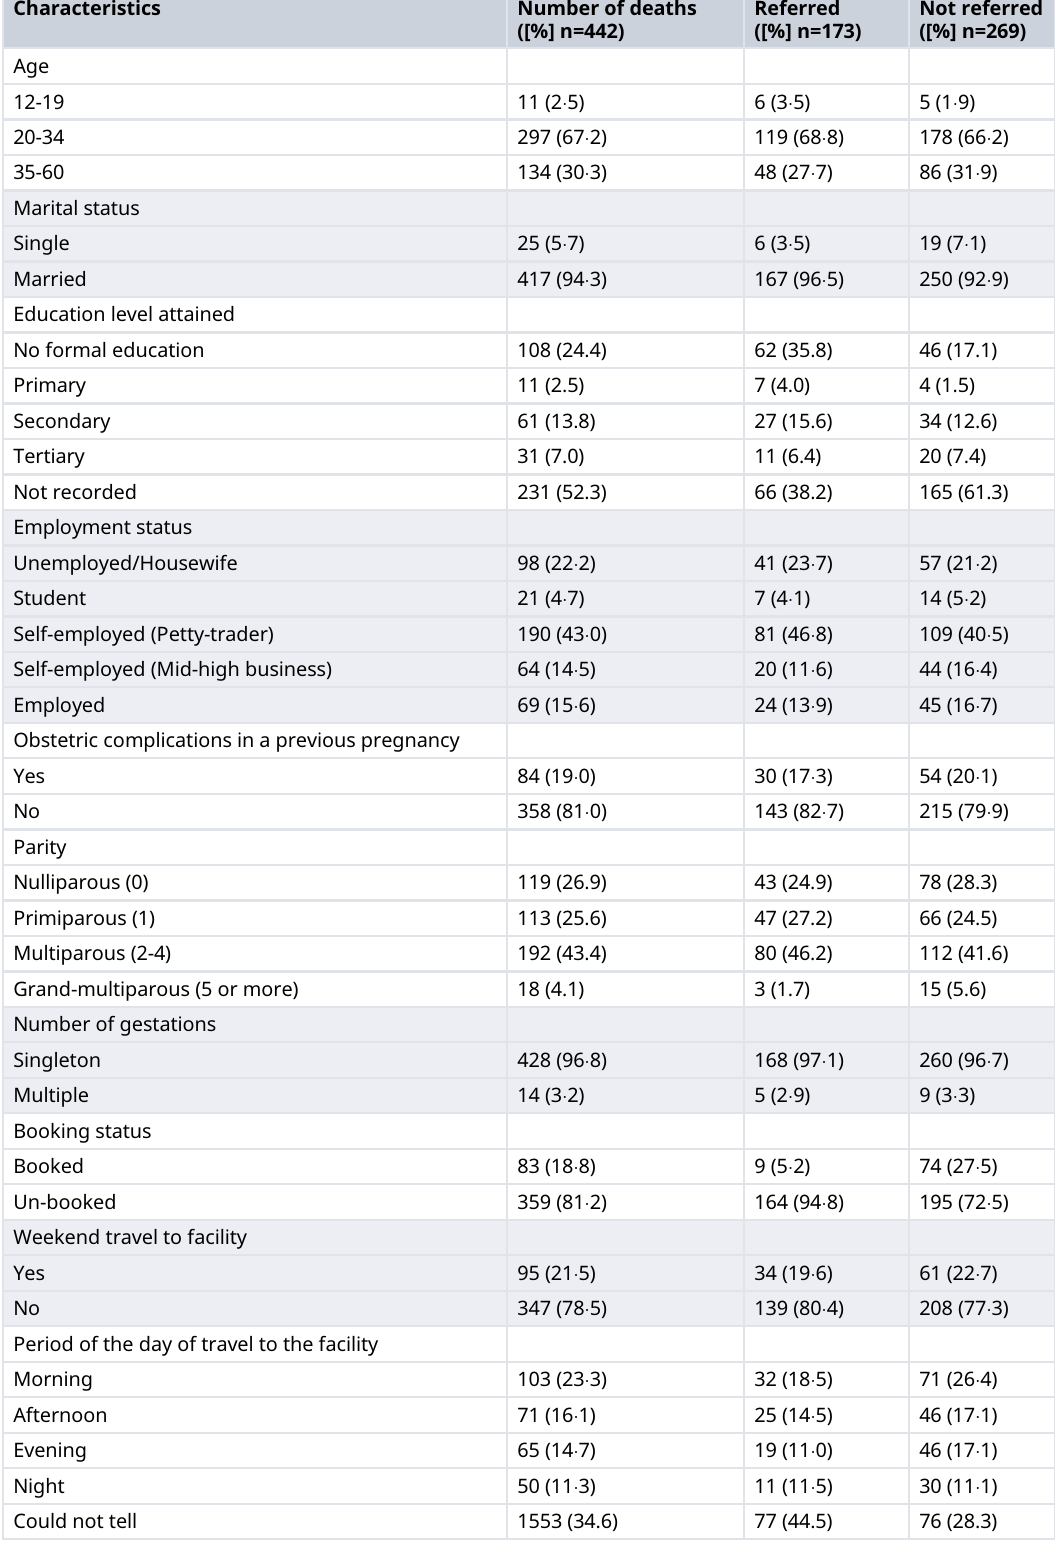
Table 2. Socio-demographics, obstetric history, characteristics of index pregnancy, and travel history of pregnant women who delivered stillbirths.